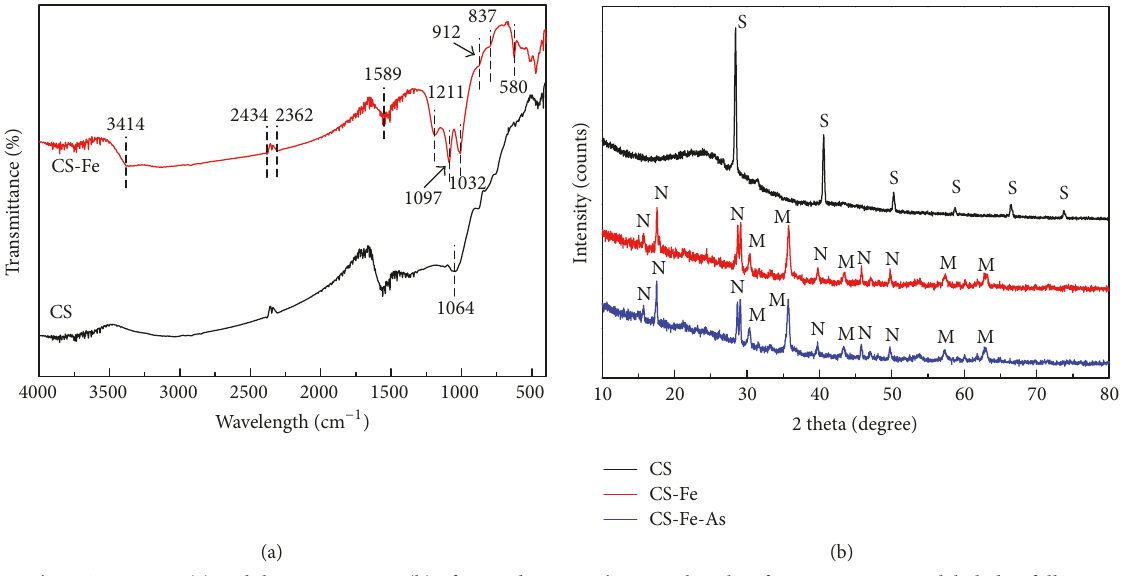
Figure 1: The FTIR spectra (a) and the XRD spectra (b) of CS and CS-Fe. The typical peaks of XRD spectra were labeled as follows: S, sylvite; M, magnetite; N,